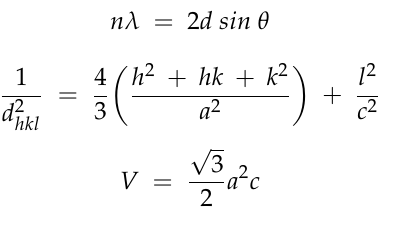
Table 1. Crystallite size (D), inter-planar spacing ( d ), lattice parameters ( a = b and c ), and volume ( V )